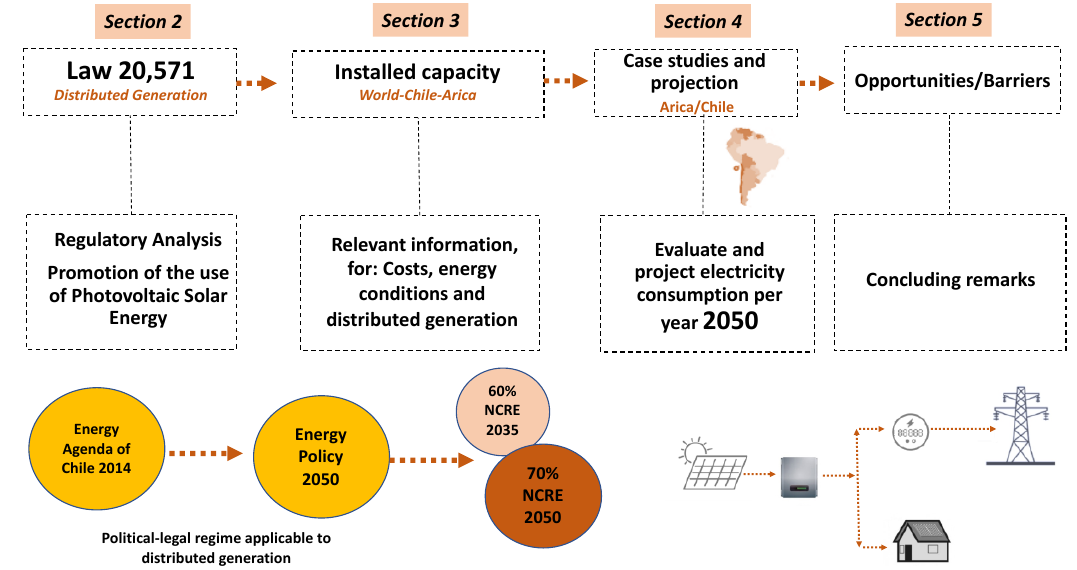
Figure 3. Applied methodology. Source: Prepared by the authors.